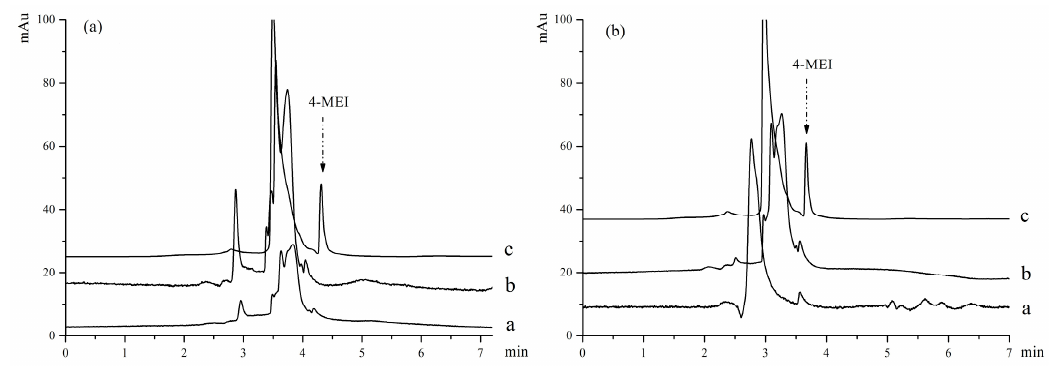
Figure 8. Chromatograms of two samples: ( a ) represents sample Shengchou; ( b ) represents sample Laochou: a—initial solutions; b—solution extracted with MNIPs; c—solution extracted with MMIPs.